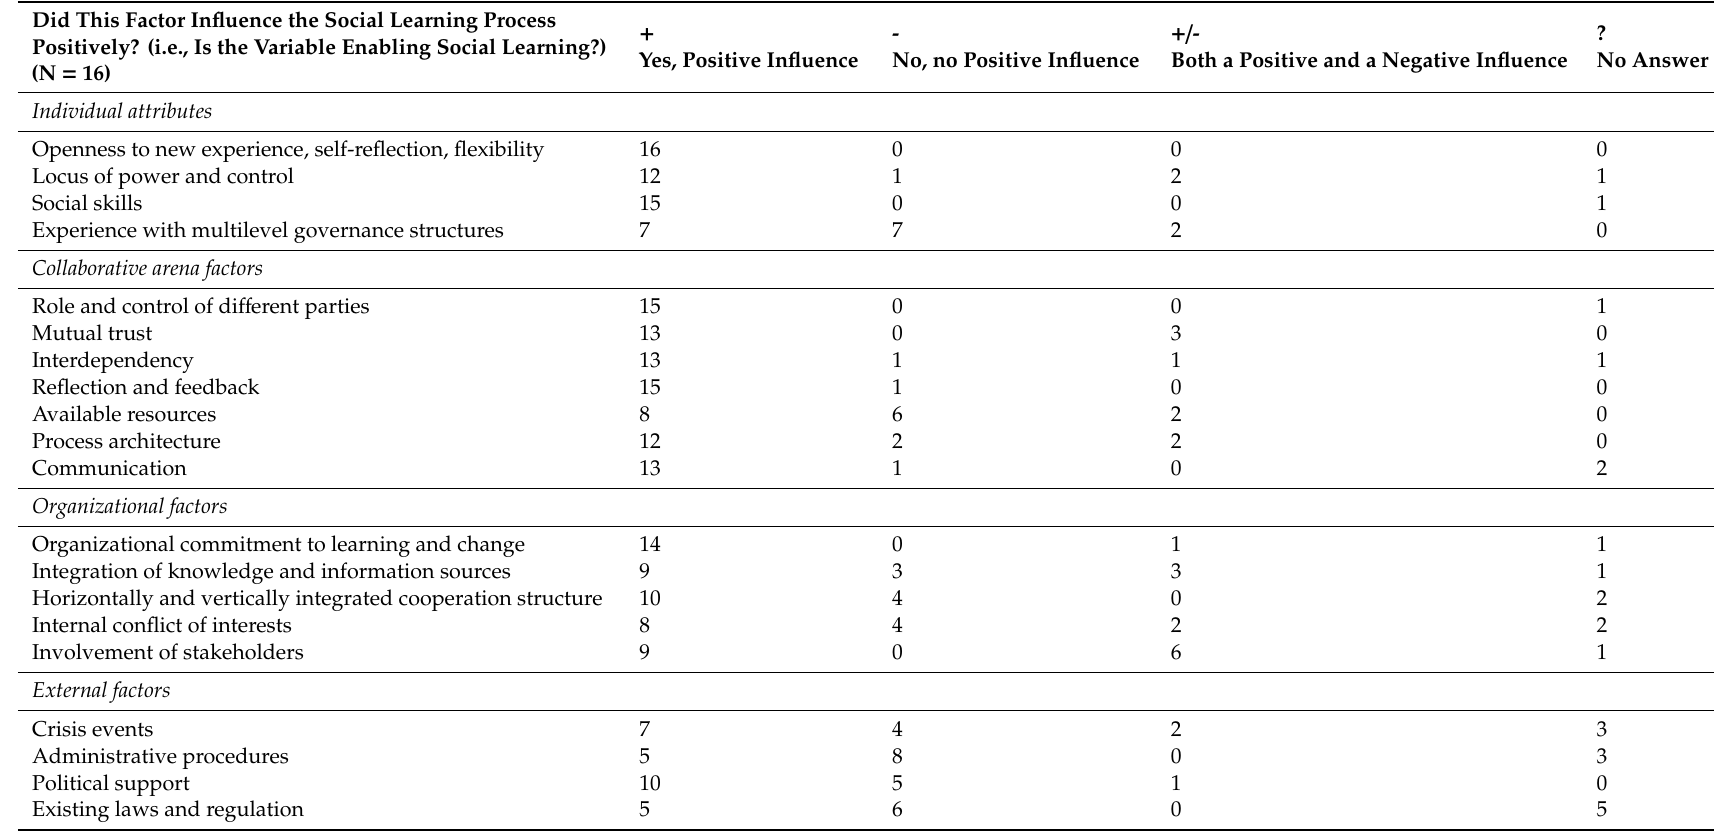
Table 5. Factors influencing the social learning process in the Room for the River